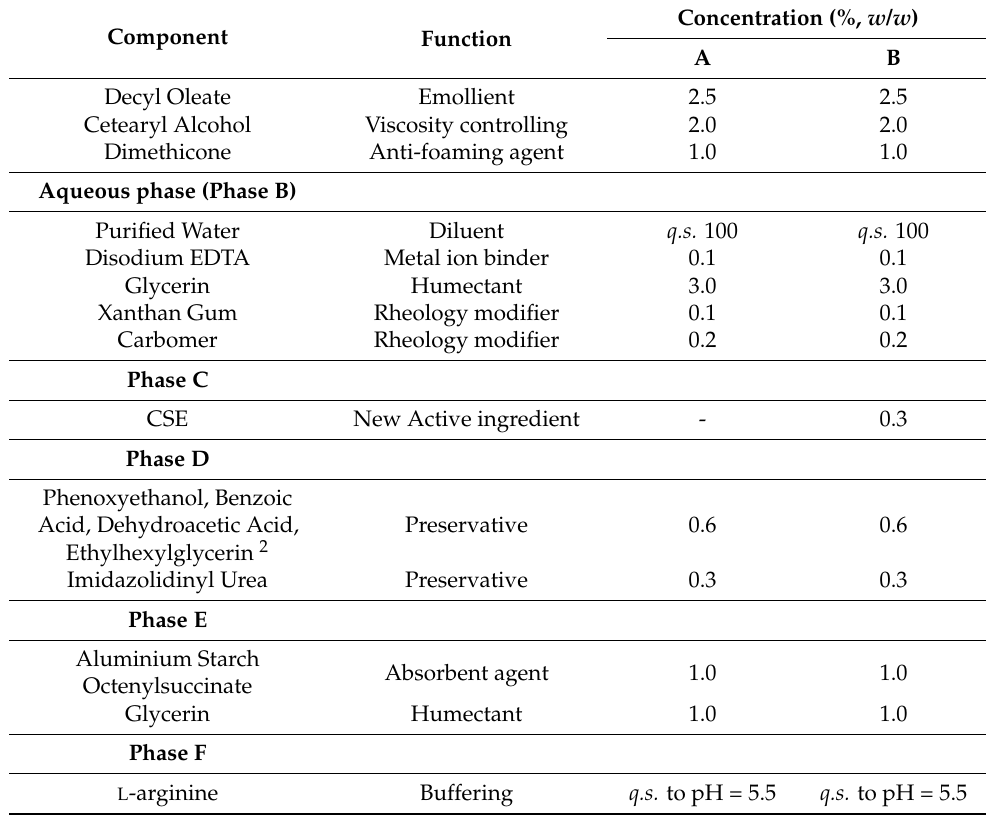
Table 1. Cont. Component Function Decyl